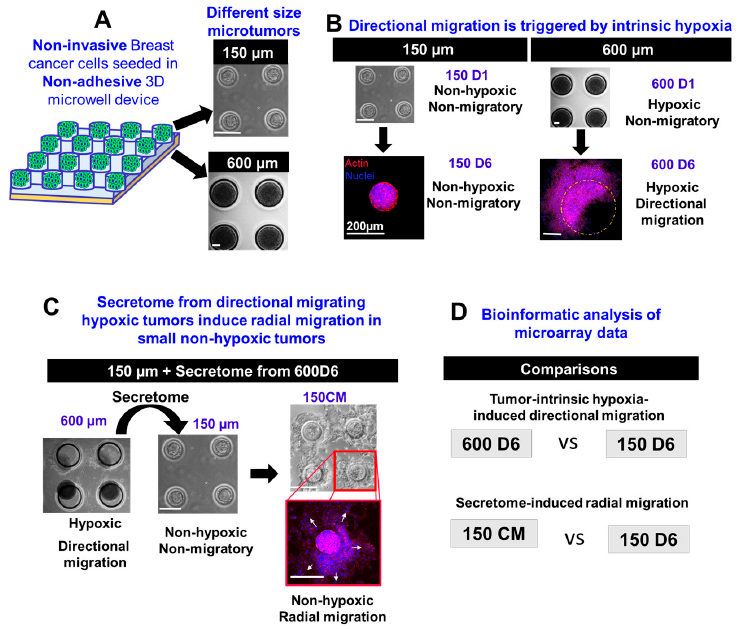
Figure 1. 3D models of breast cancer recapitulate two distinct modes of collective migration due to different microenvironmental factors: tumor intrinsic hypoxia and secretome. ( A ) Schematic representation of our 3D hydrogel microwell system in which we can generate small (150 µm) and large (600 µm) microtumors. ( B ) Small microtumors are non-hypoxic and non-migratory, whereas large microtumors develop size-related intrinsic hypoxia and migrate directionally. ( C ) We can induce radial migration by treating the small non-hypoxic non-migratory tumors with the secretome of large hypoxic directional migrating tumors. ( D ) We performed bioinformatic analysis of microarray data to study the changes in gene expression of large hypoxic directional migrating microtumors and small non-hypoxic radially migrating microtumors compared to non-hypoxic and non-migratory microtumors.